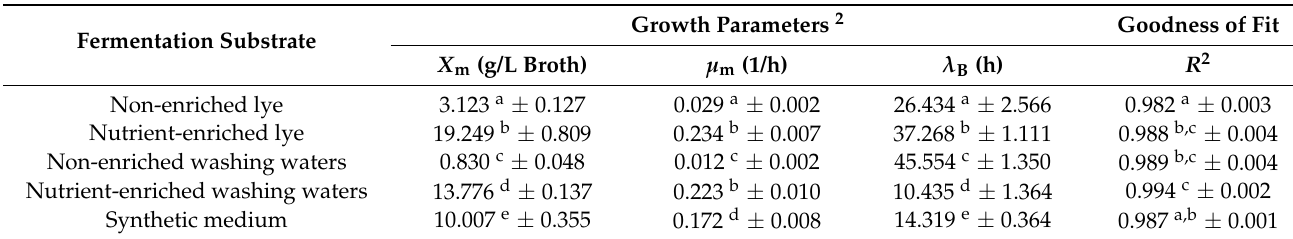
Table 1. Growth kinetic parameters (modified Logistic model) of B. trispora in non-sterile lye and washing waters without or after enrichment with nutrients as well as in synthetic medium (fermentation time: 6 days) 1 . Fermentation